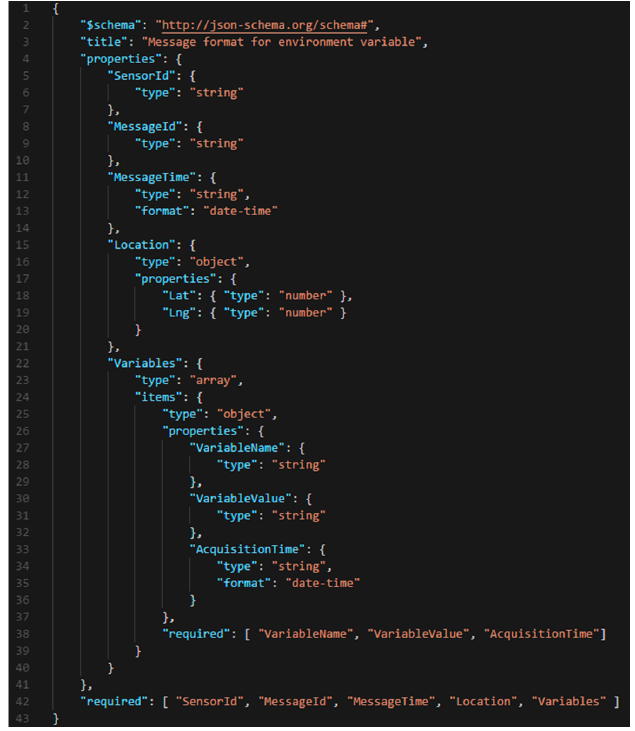
Figure 4. JSON schema for environmental variable message.